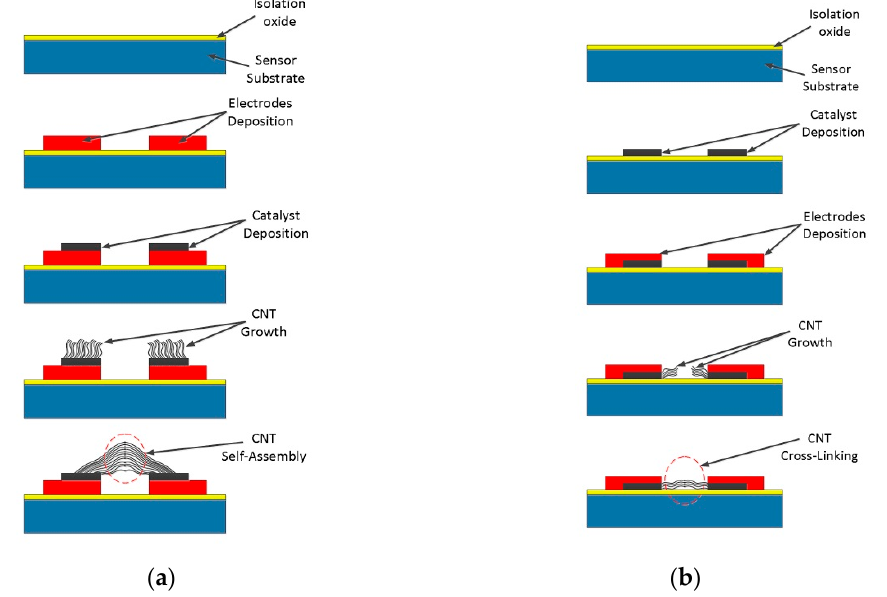
Figure 2. Fabrication process of the CNT based sensor using CVD technique: ( a ) vertical growing and self-assembling; ( b ) horizontally growing. Reproduced from [29], courtesy of Michael De Volder.